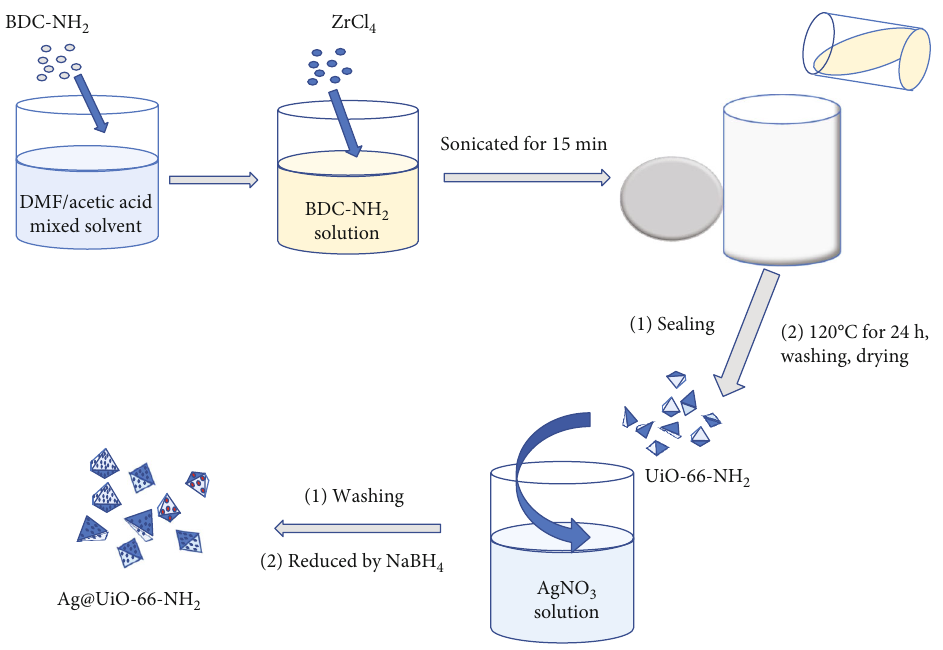
Figure 14: Schematical illustration of the preparation of Ag@UiO-66-NH